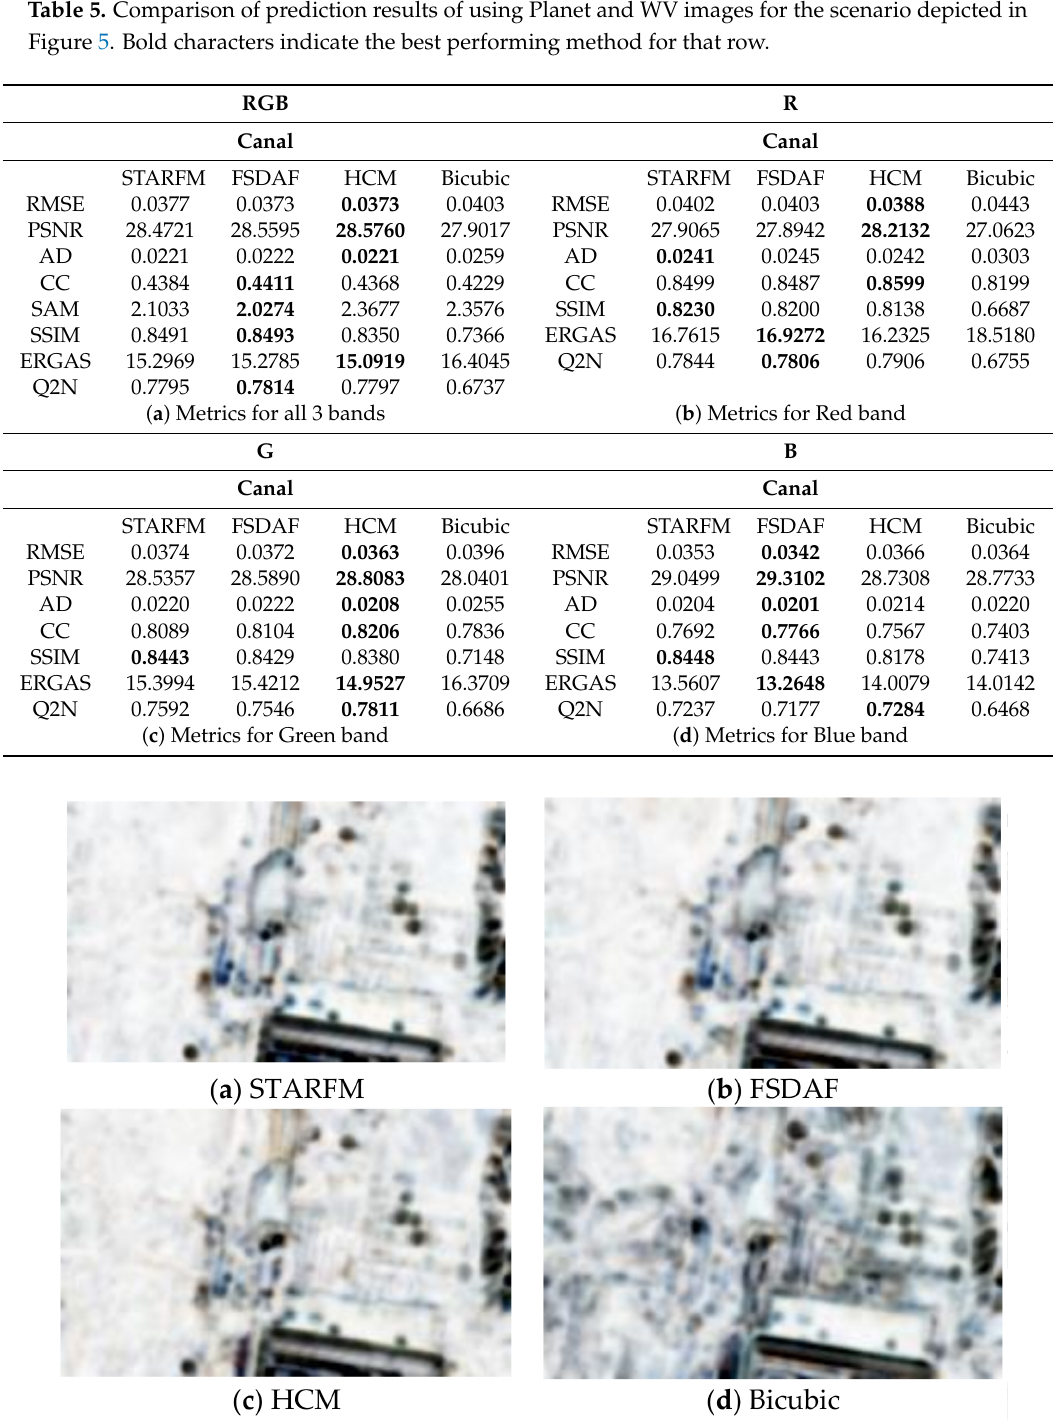
Figure 7. SSIM (Structural Similarity) maps of the Canal scenario using different methods. ( a – d ) are the maps for STARFM, FSDAF, HCM, and bicubic,